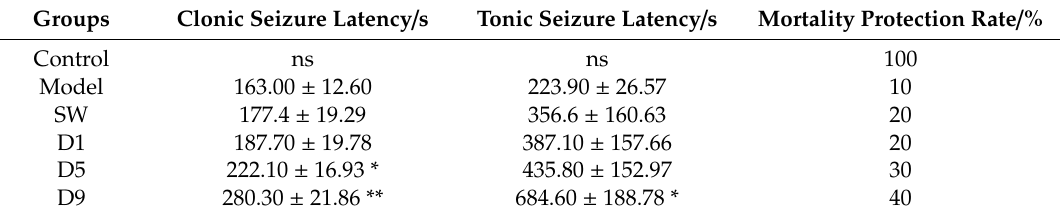
Table 1. E ffi cacy of B. batryticatus samples on strychnine-induced epileptic seizures in mice. Groups Clonic Seizure Latency /